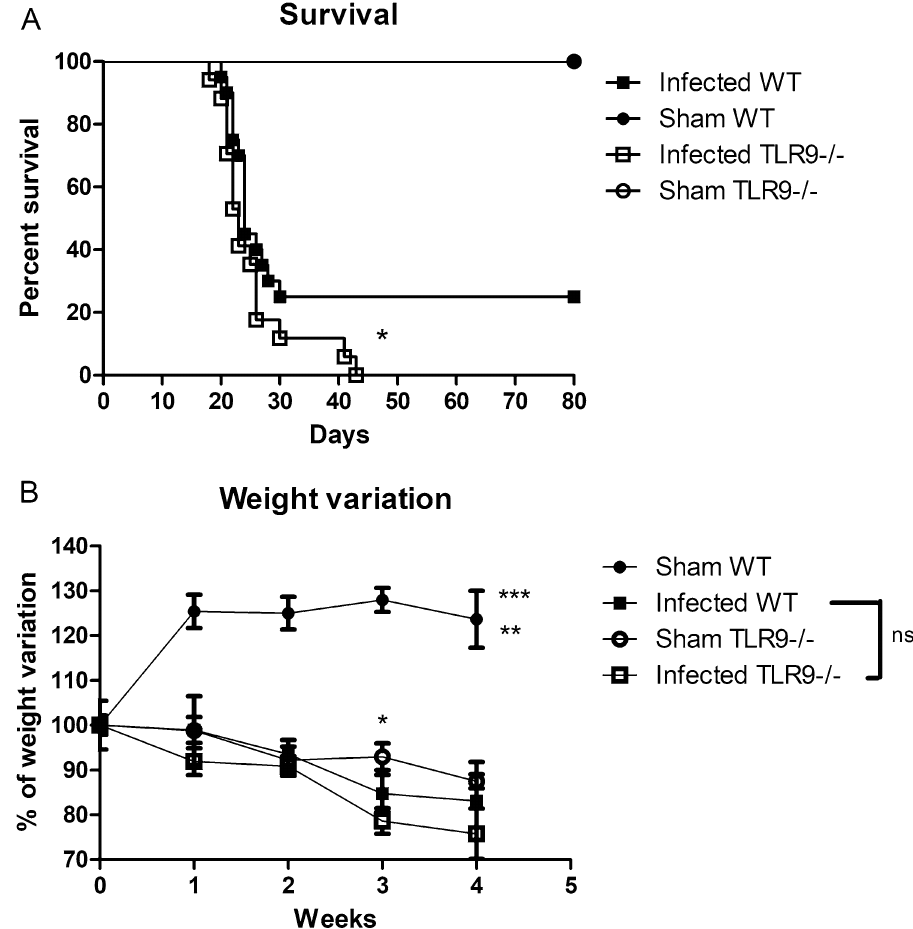
Figure 1. Analysis of susceptibility of TLR9 −/− and WT mice to C. gattii infection. ( A ) Survival curves of infected C57BL/6 WT (n = 20) and TLR9 −/− (n = 17) mice. Mice were infected with 10 4 C. gattii R265 belonging to serotype IIa. Sham WT (n = 6) and TLR9 −/− (n = 6) mice given with vehicle (PBS) only were used as controls. Log-rank test (Mantel-Cox test): * P ≤ 0.05. ( B ) The percentage change in weight of infected WT (n = 11) and TLR9 −/− (n = 10) mice, as well as the Sham groups (Sham WT and Sham TLR9 −/− ) (n = 5 per group), was determined through weekly mass measurements over 28 days (0, 7, 14, 21 and 28 days after inoculation). Black squares represent infected WT mice, black balls represent uninfected WT mice, white squares represent infected TLR9 −/− mice, and white balls represent uninfected TLR9 −/− animals. One-Way ANOVA (** P ≤ 0.01) and Two- Way ANOVA with Bonferroni posttest (* P ≤ 0.05; *** P ≤ 0.001); ns = not statistically significant. Graphs show the union of the results from 4 similar and independent